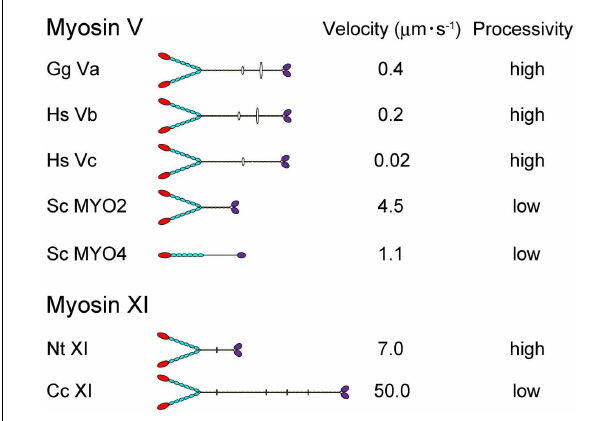
FIGURE 1 |The velocity and processivity of myosinVs and myosin XIs characterized in vitro . GgVa, Gallus gallus myosinVa (Mehta et al., 1999); HsVb, Homo sapiens myosinVb (Watanabe et al., 2006); HsVc, Homo sapiens myosinVc (Takagi et al., 2008;Watanabe et al., 2008); Sc Myo2 and 4, Saccharomyces cerevisiae myosinV (Reck-Peterson et al., 2001); Nt XI, Nicotiana tabacum 175-kDa myosin XI (Tominaga et al., 2003); and Cc XI, Chara corallina myosin XI (Ito et al.,